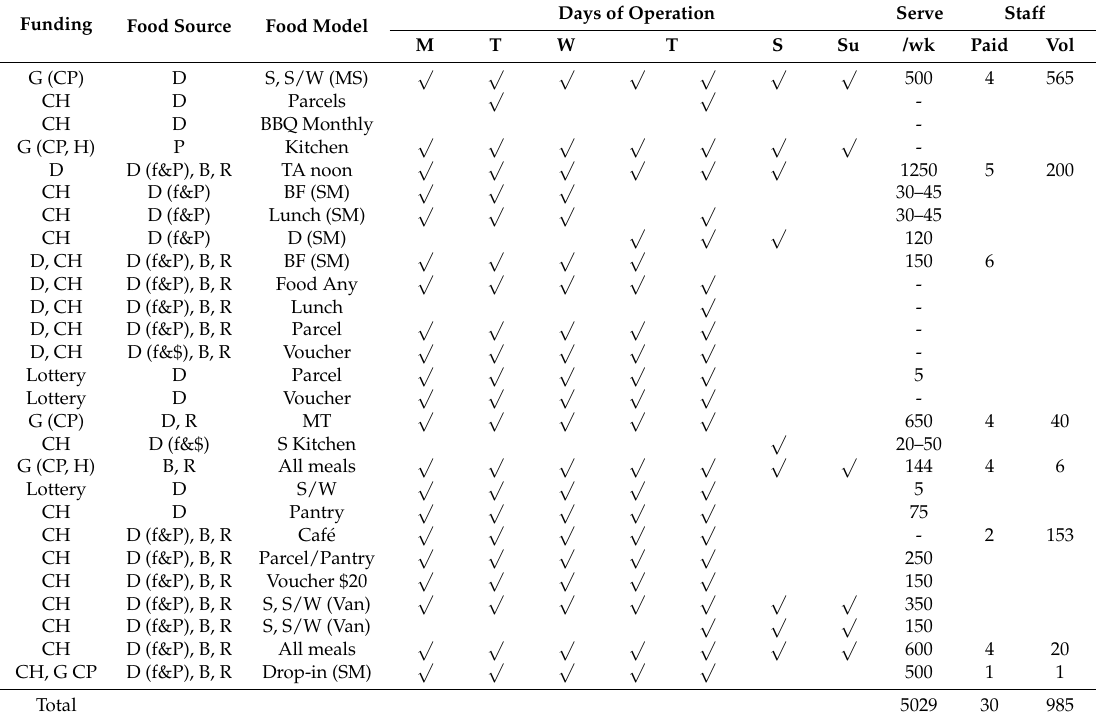
Table 2. Snapshot of the types and extent of direct food service in inner-city Perth, January